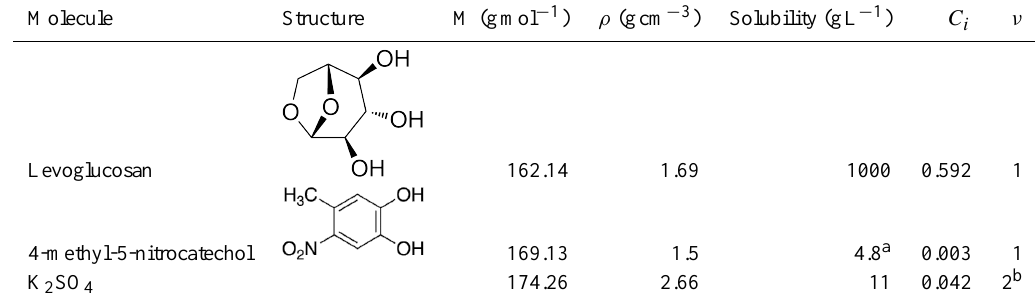
Table 1. Chemical properties of the different particle types investigated in this study and the parameters used in predicting κ . Molecule